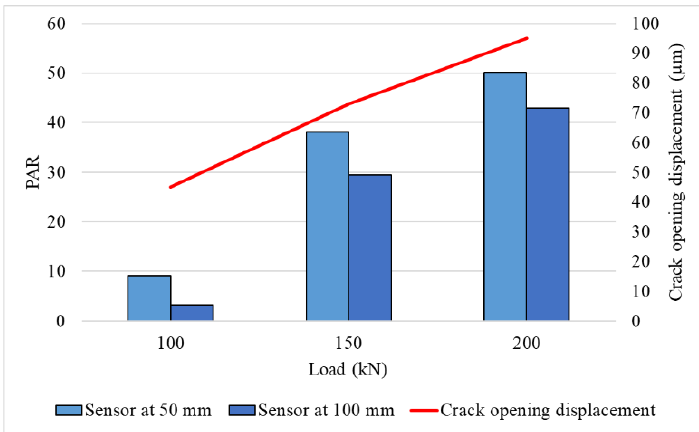
Figure 19. Variation of PAR and crack opening displacement with respect to load.